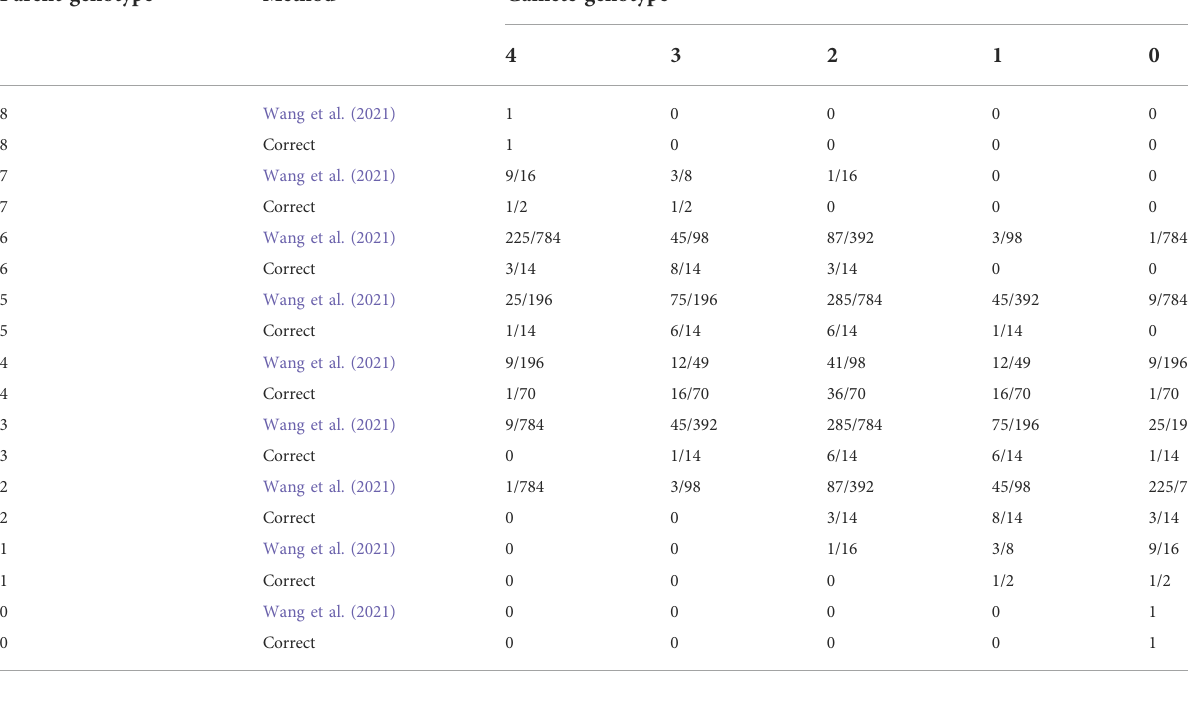
TABLE 1 Segregation frequencies for an autooctoploid when there is no double reduction, either according to Table 1 from the study by Wang et al. (2021) or according to the correct calculation using the hypergeometric distribution (Eq. 4). The two approaches are different, so the general model for meiosis in the study by Wang et al. (2021) is